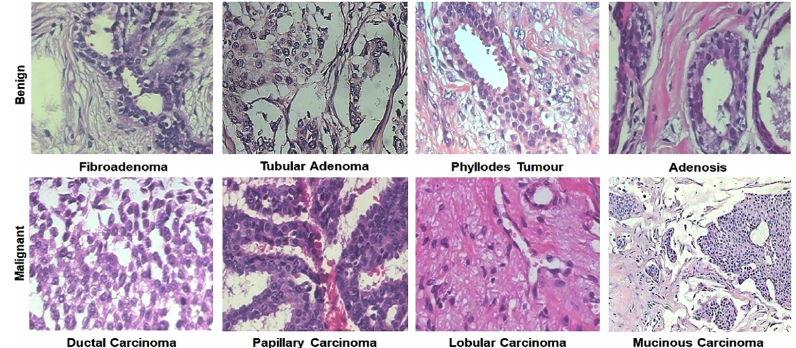
Figure 9. Representative H&E stained images from the BreakHis